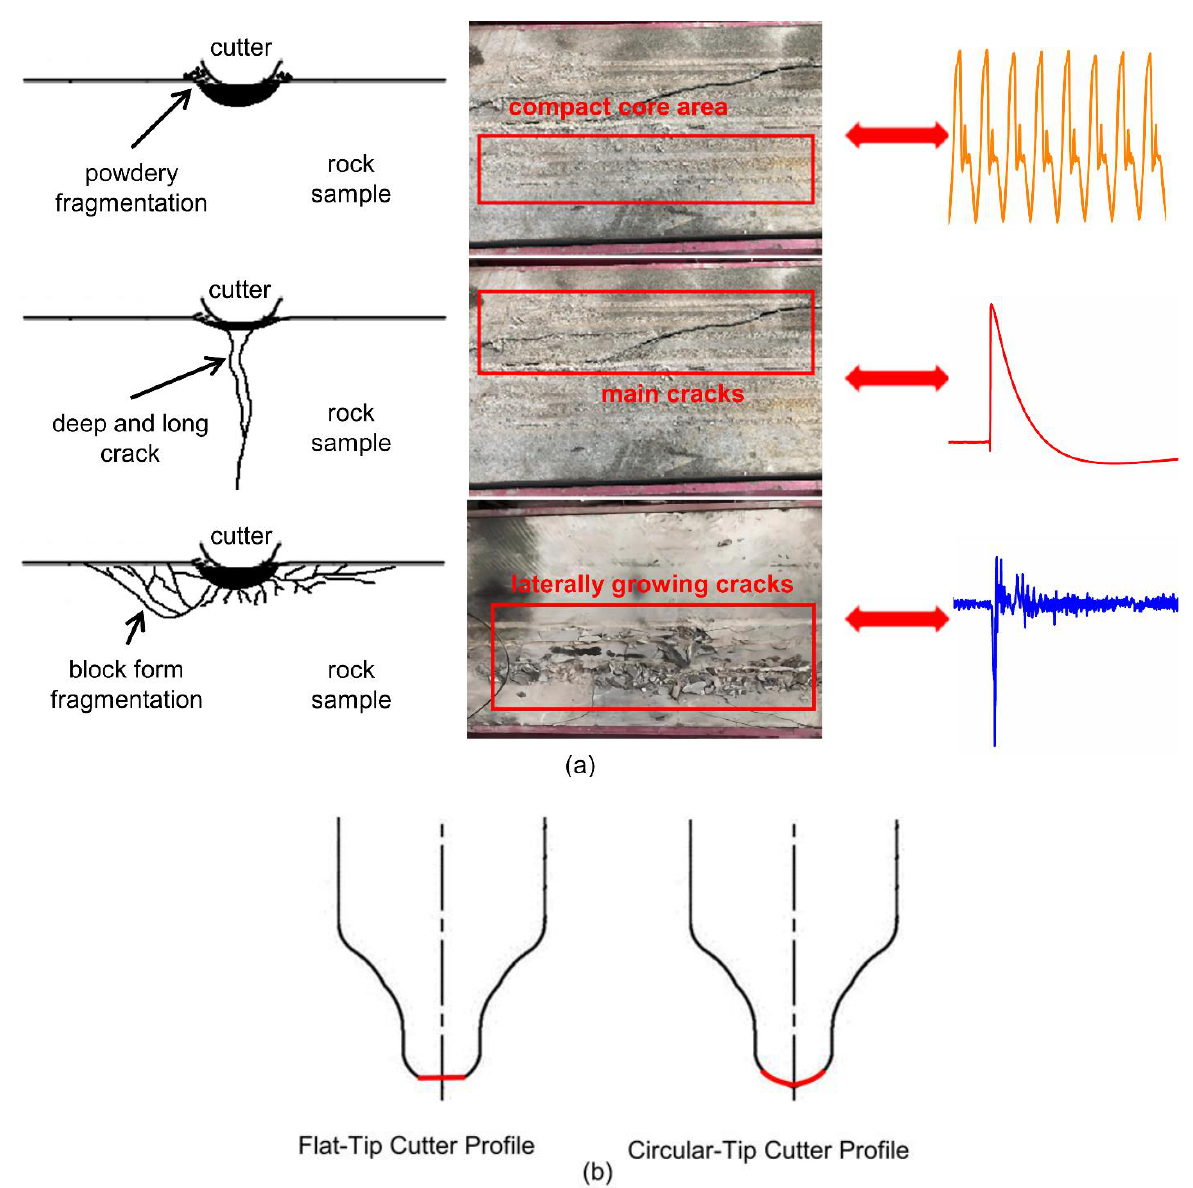
Figure 8. Rock Fragmentation and cutter profiles: ( a ) three main cleavage types of rock samples; The three colored lines indicate the vibration time-domain characteristics of the corresponding rock states, respec-tively; ( b ) flat-tip cutter profile and circular-tip cutter profile.